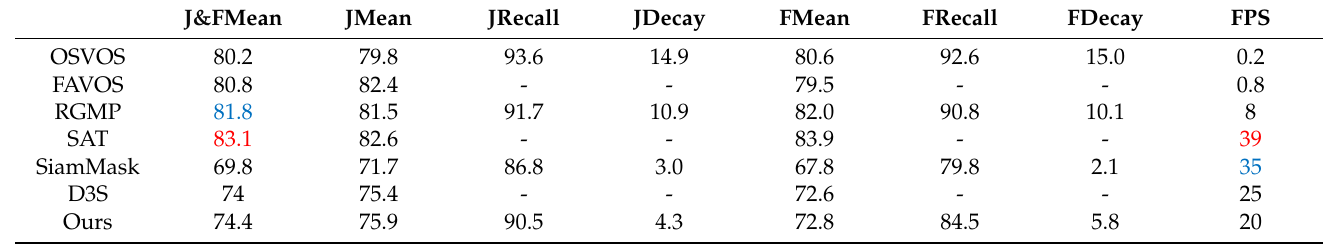
Table 5. Comparison of properties on the public DAVIS2016 segmentation dataset. Red and blue represent 1st and 2nd, respectively.